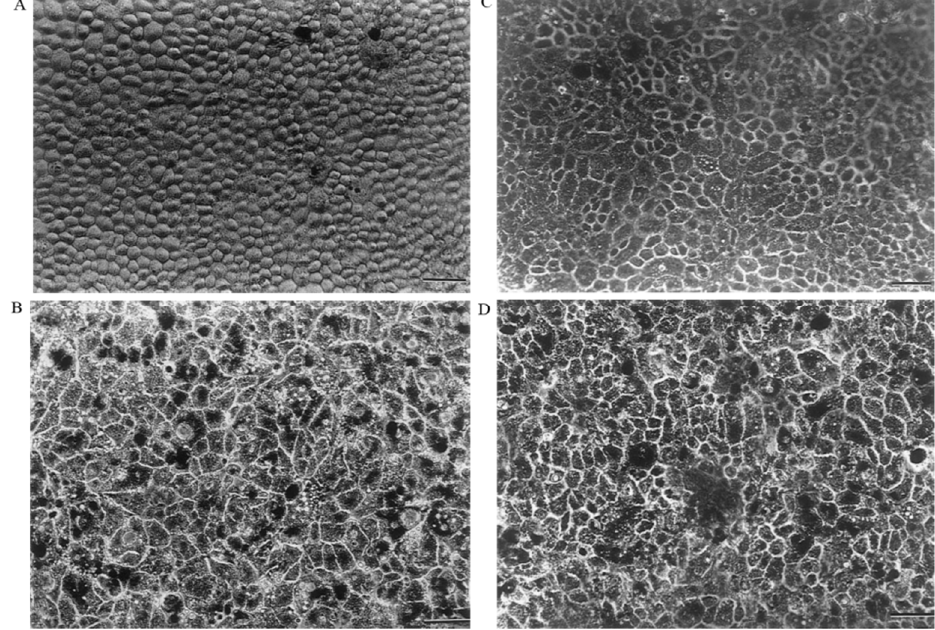
Figure 5. ( A ) Pig RPE cells were cultured on a pig lens capsule (100x), scale bar = 50 μ m; ( B ) human RPE cells on a human lens capsule (100×), scale bar = 50 μ m; ( C ) pig RPE cells cultured on a hydrogel (100×), scale bar = 50 μ m; ( D ) human RPE cells cultured on a hydrogel (100×), scale bar = 50 mm. Reprinted from [80].